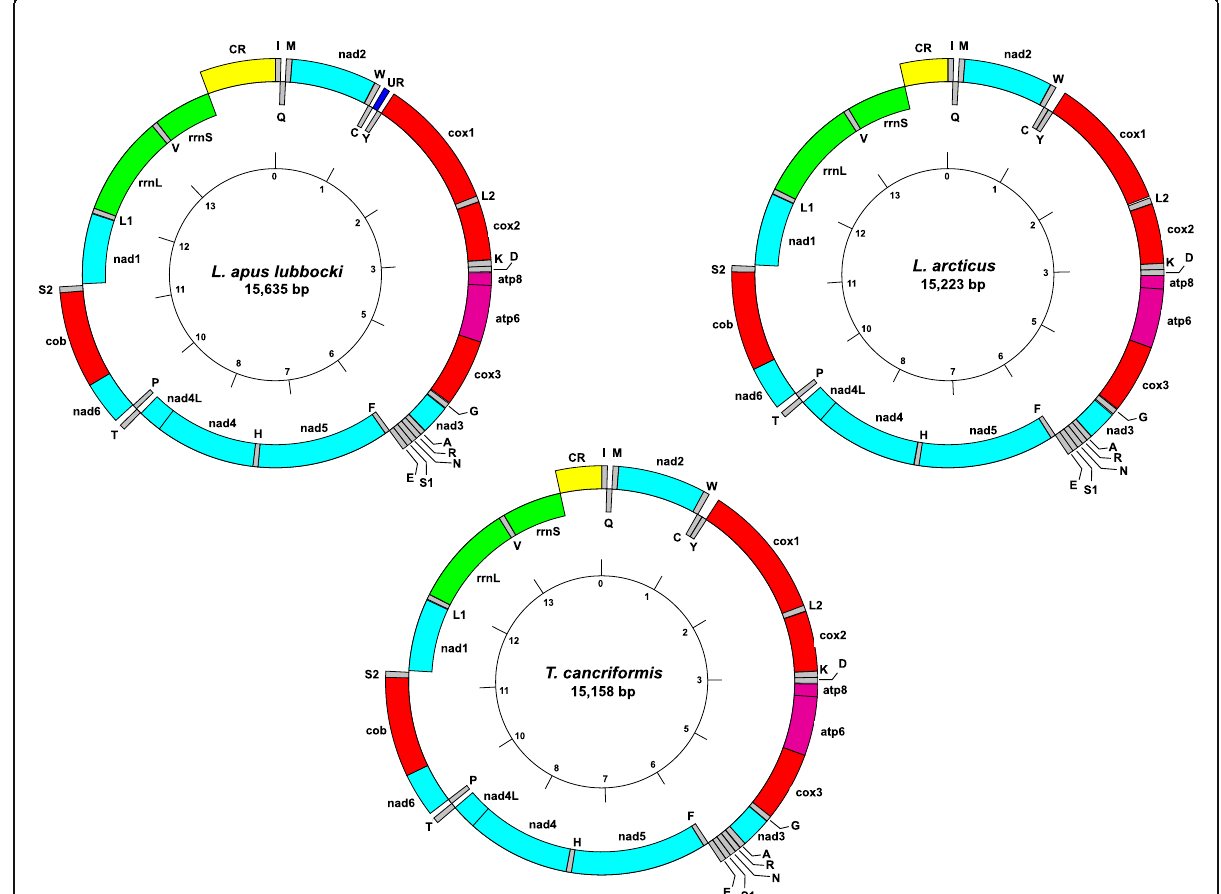
Fig. 1 Schematic structures of newly sequenced mitochondrial